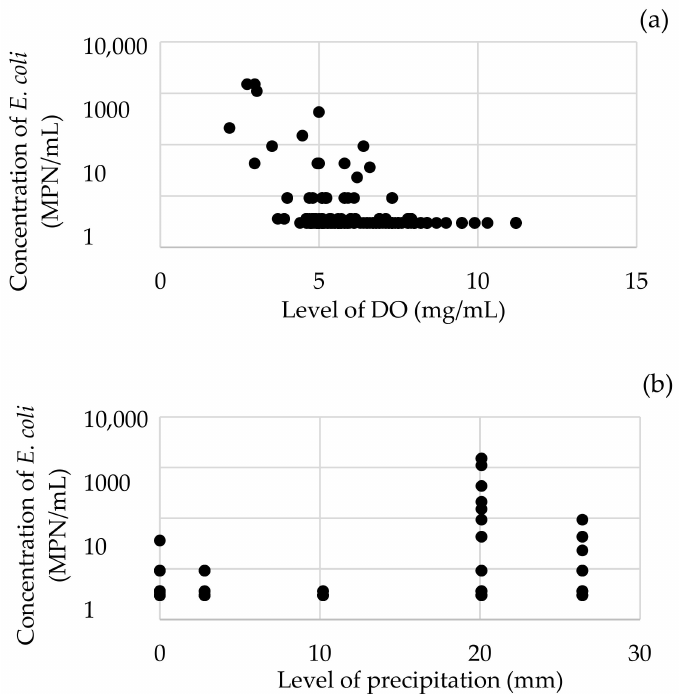
Figure 3. Predicted mean concentration of E. coli (MPN/mL) in coastal water samples from oyster production regions in Thailand as a function of: ( a ) level of DO (mg/L); ( b ) level of precipitation